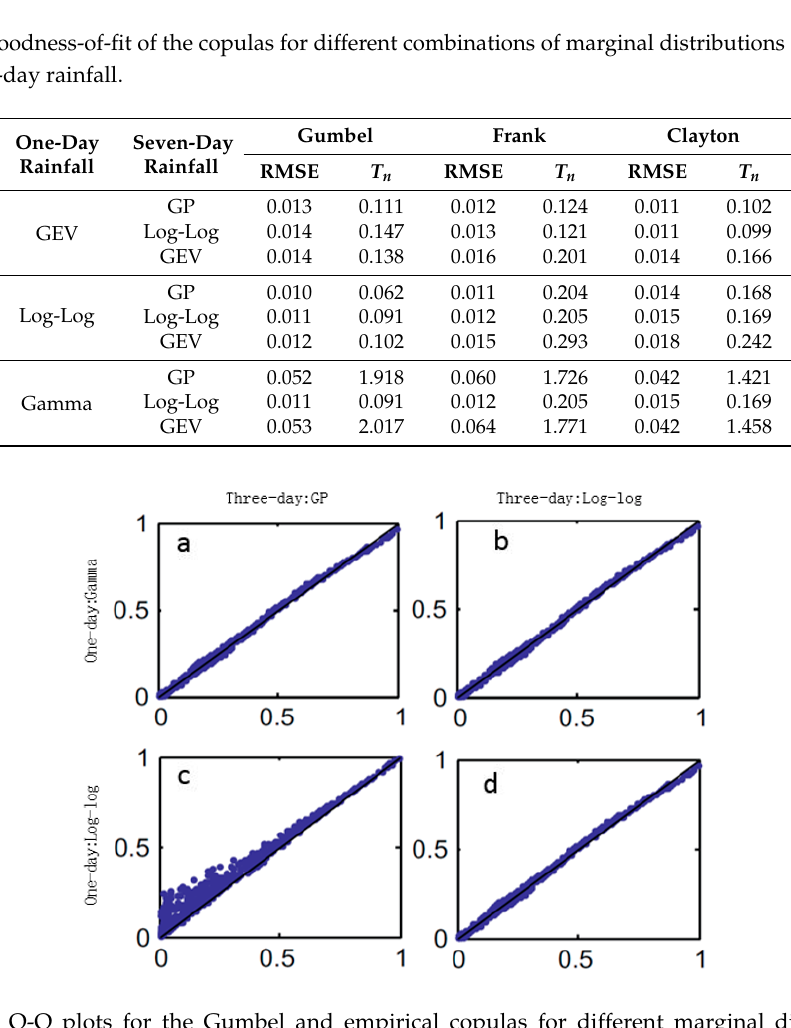
Figure 3. Q-Q plots for the Gumbel and empirical copulas for different marginal distribution combinations of one-day rainfall and three-day rainfall. ( a ) Gamma (one-day) vs. GP (three-day); ( b ) Gamma (one-day) vs. Log-log (three-day); ( c ) Log-log(one-day) vs. GP (three-day); ( d ) Log-log (one-day) vs. Log-log (three-day).